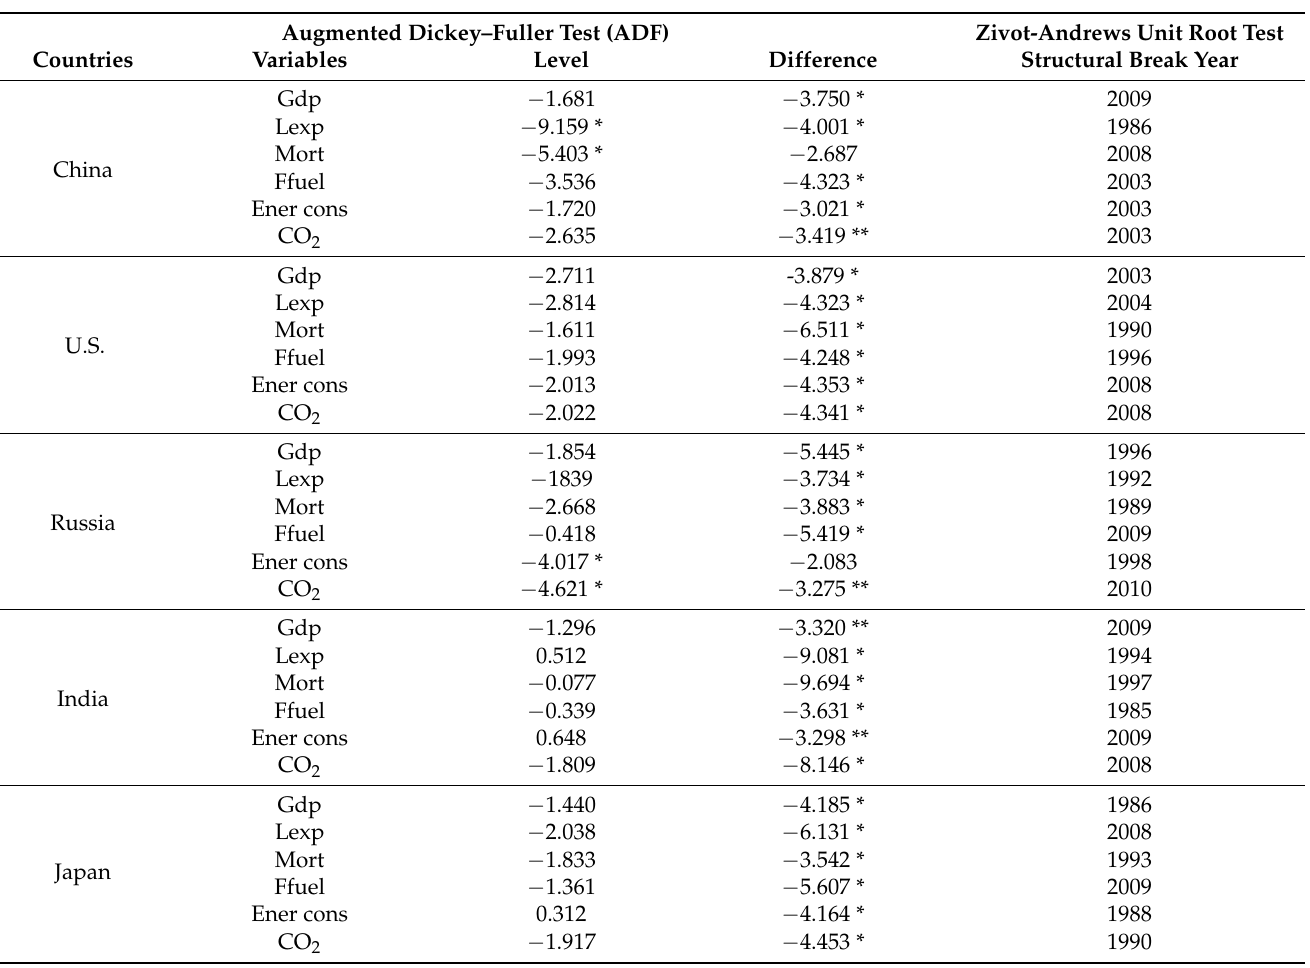
Table 7. Augmented Dickey–Fuller (ADF) and Zivot-Andrews unit root test for all of the se- lected